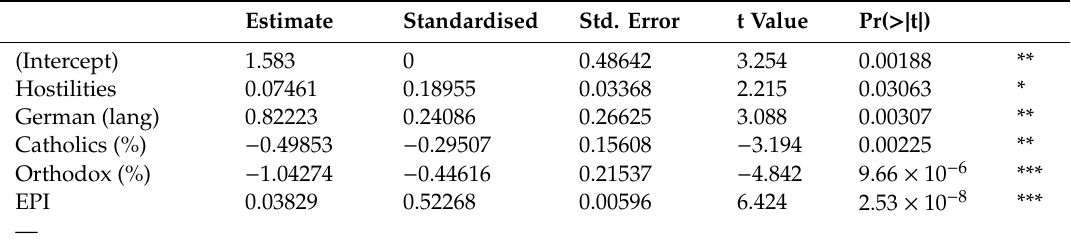
Table 10. Model 4. Competitiveness in Europe and the Americas (cross-validation method) (Author’s